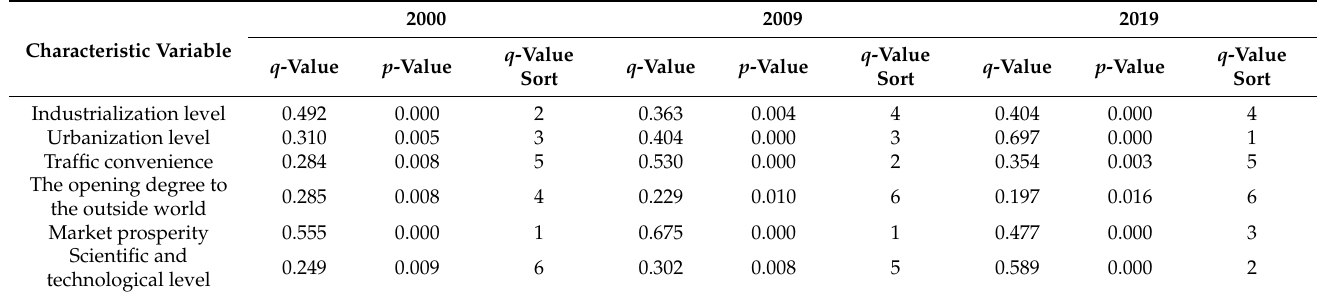
Table 4. The detection results of factors affecting economic spatial